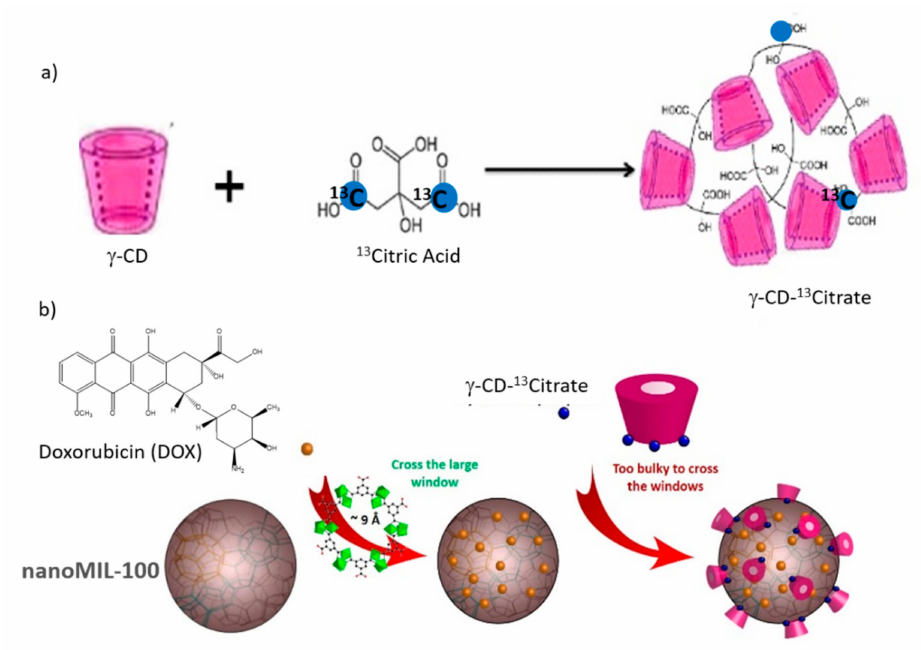
Figure 15. ( a ) Synthesis of γ CD- 13 citrate polymers (CD- 13 CO); ( b ) Schematic representation of the highly porous MIL-100(Al) nanoparticles loaded with DOX and then coated with CD- 13 CO [48].